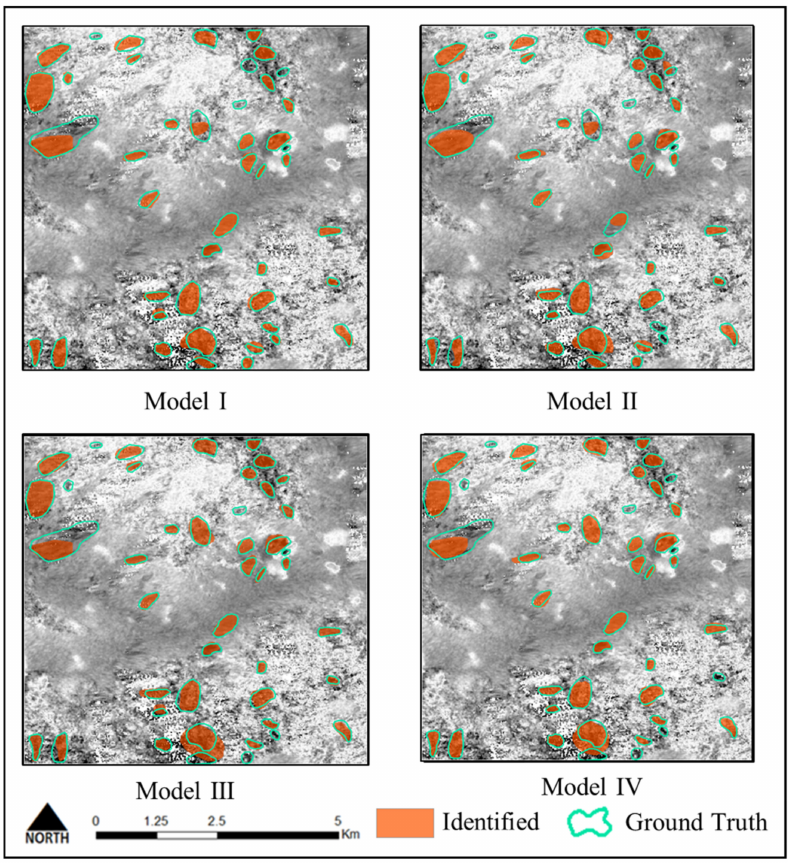
Figure 20. Comparison of the different modules for test area A.